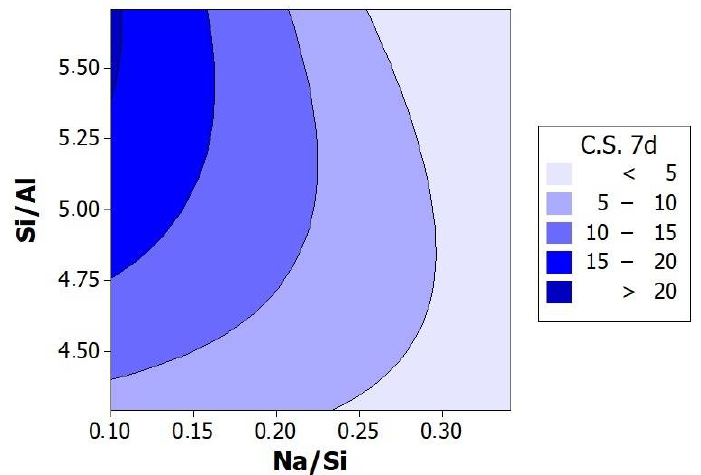
Figure 3. Effect of the molar ratios of Na/Si and Si/Al on the compressive strength (C.S.) of hybrid cement (paste) after 7 days of curing: the contours represent the strength levels.